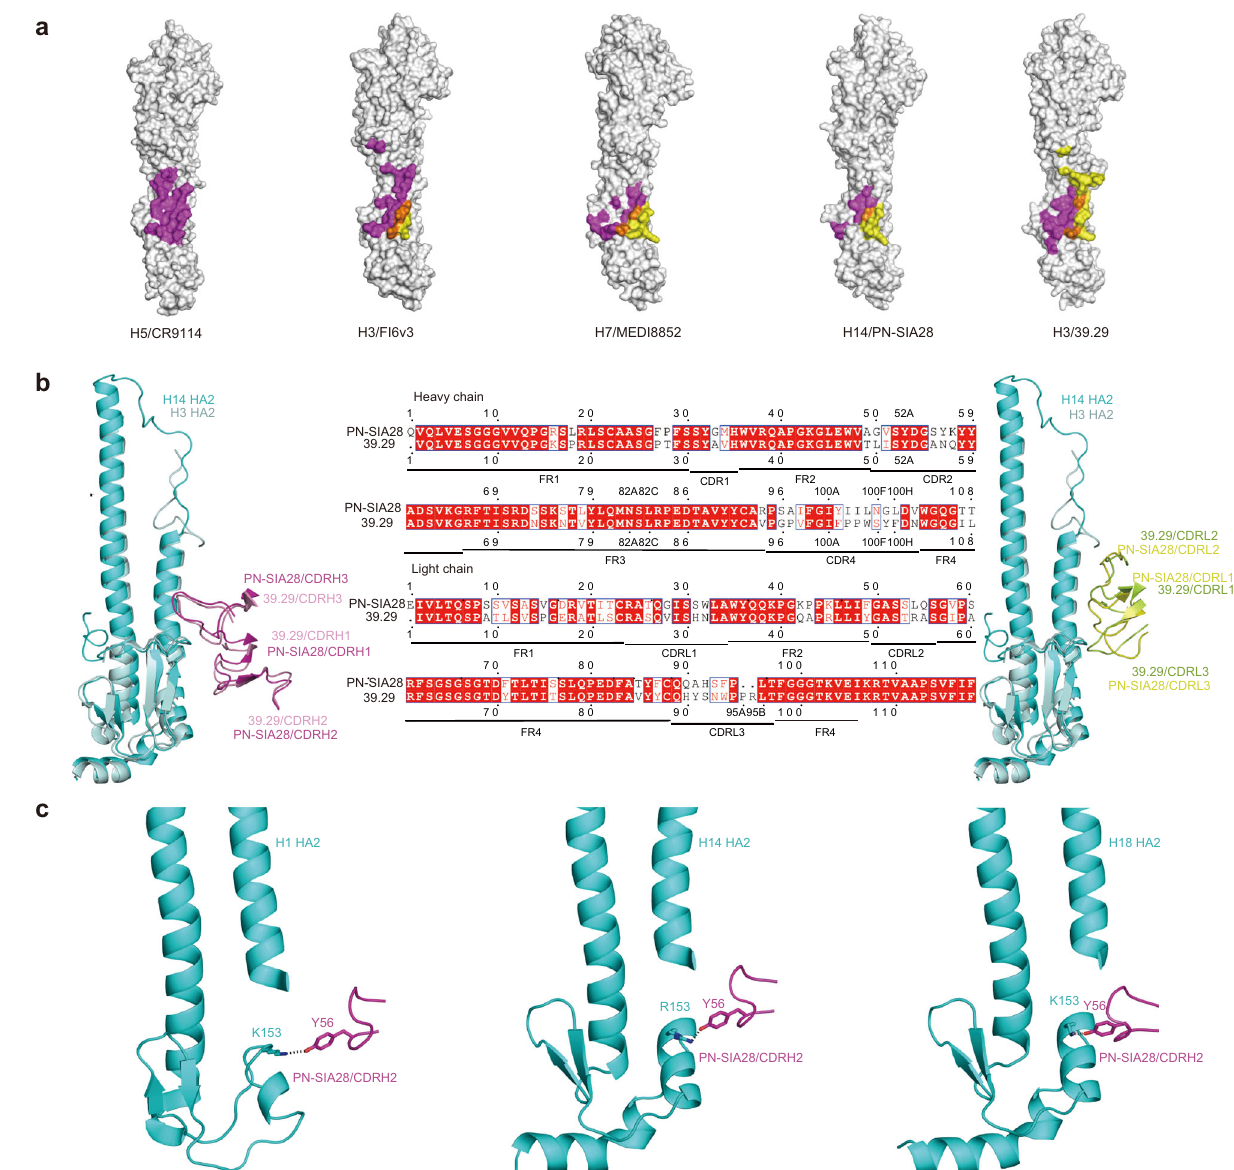
Fig. 5 | Binding speci fi cities of PN-SIA28 compared to other stem-bound anti- bodies. a Epitopes of different broadly neutralizing antibodies on the HA surface. Residues of HA contacted by the heavy chain are colored magenta, residues of HA contacted by the light chain are colored yellow, and residues of HA contacted by both chains are colored orange. b PN-SIA28 interactions with H14 and comparison to the 39.29 interaction with H3. Overlay of PN-SIA28 bound to H14 and 39.29 bound to H3. HA2 of H14 and H3 are colored cyanand palecyan. The heavy chains